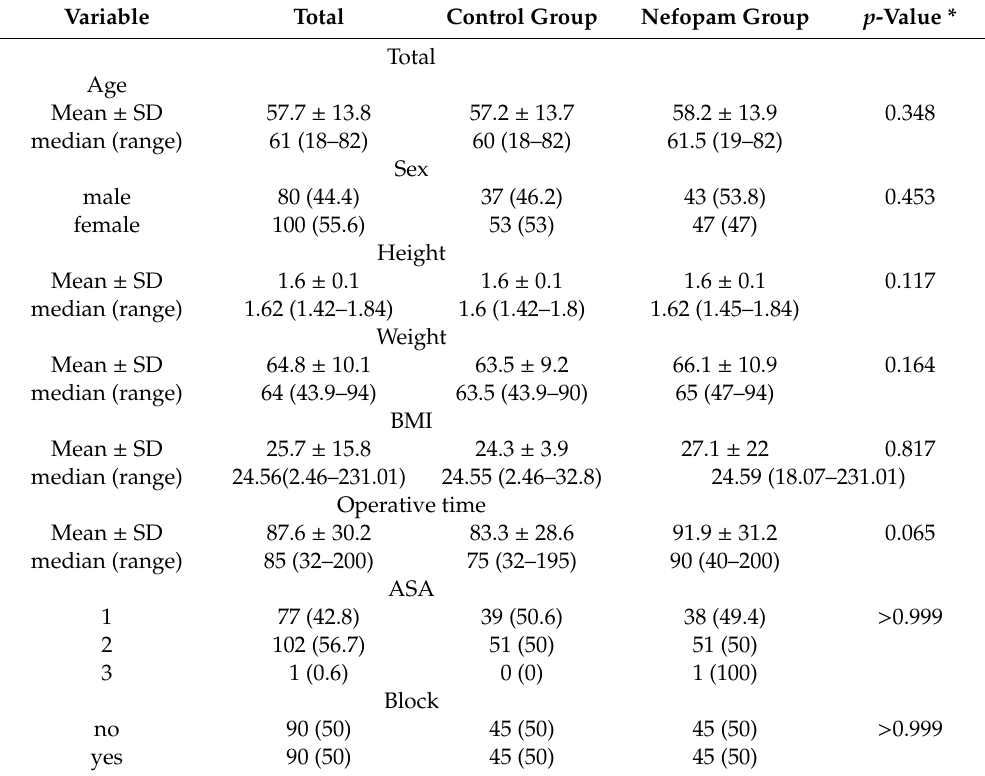
Table 1. Patient data description.